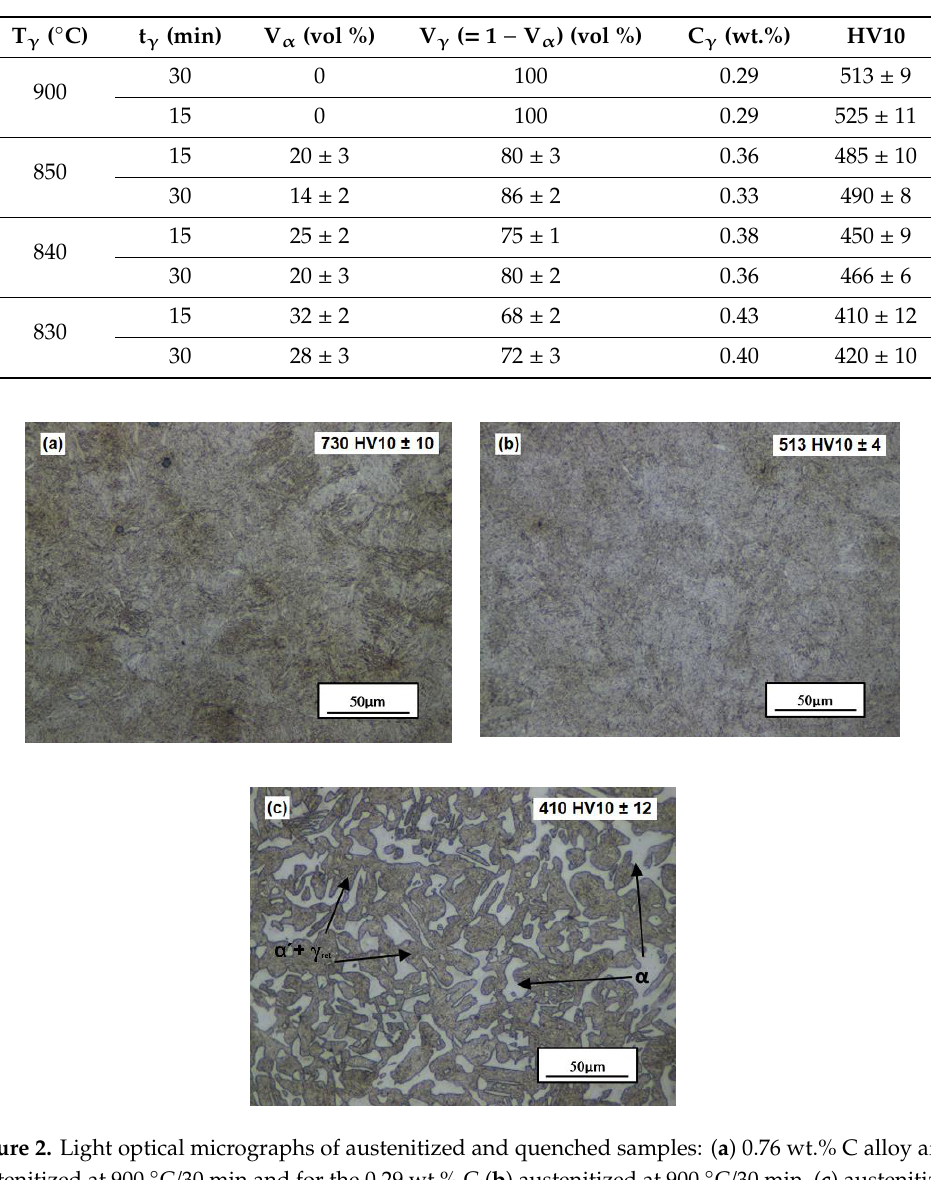
Table 3. For the 0.29 wt.% C alloy, metallographic measurements of proeutectoid ferrite ( α ) fraction V α . V γ stands for the amount of austenite at the mentioned T γ -t γ conditions. C γ is the estimated carbon content in the austenite calculated as described in the main text. HV10 is at hardness Vickers load 10 kg.